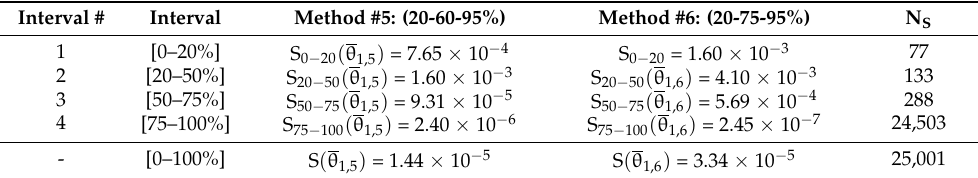
Table 15. Comparison between methods #5 and #6 in terms of time-domain model performance indices for different intervals of the process reaction curve for both identified models. The time- domain performance index for the whole response is also included in this table. N S represents the number of points for each